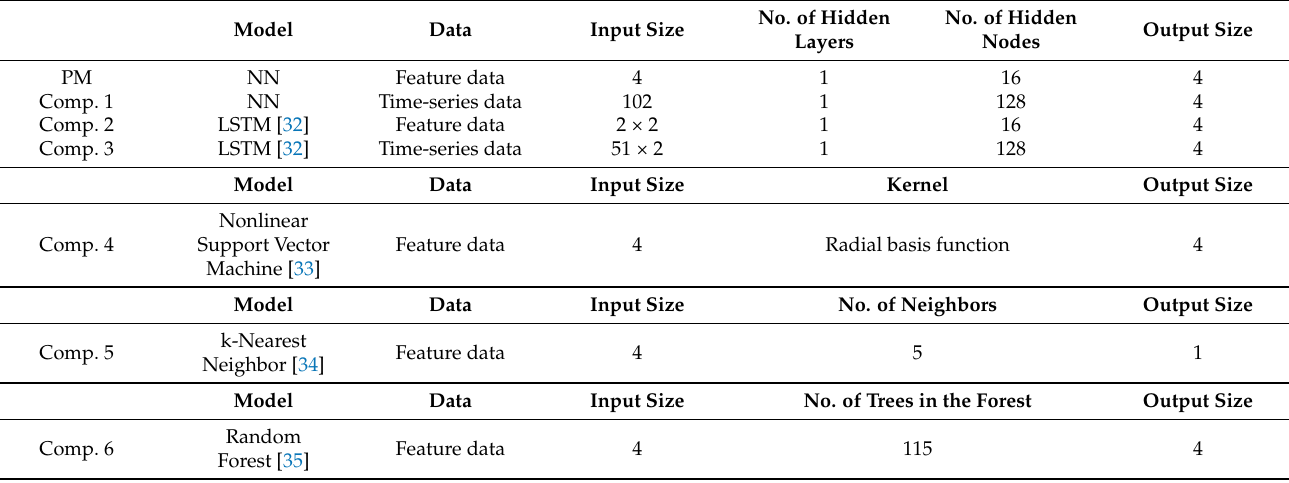
Table 4. Overview of each method.